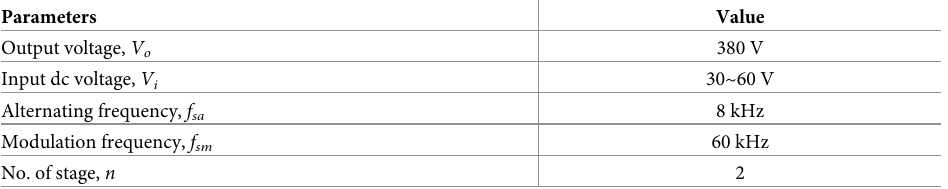
Table 3. Specifications of the proposed converter prototype.